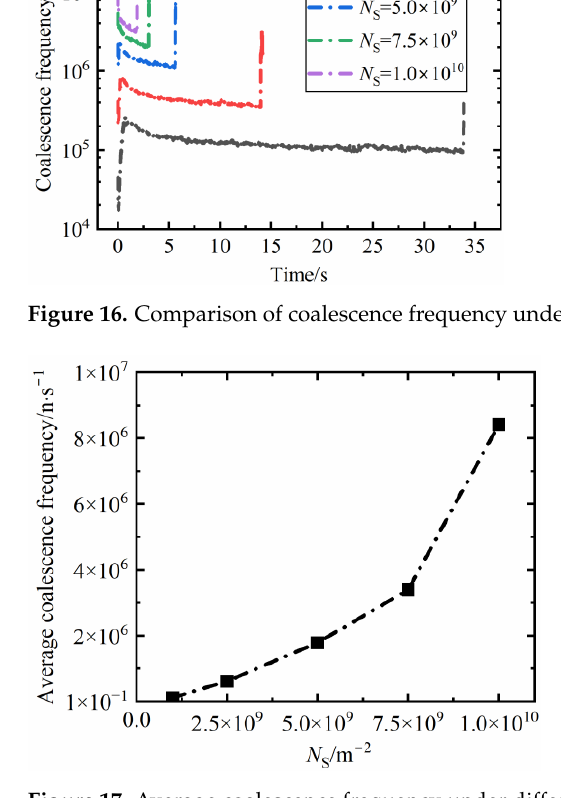
Figure 17. Average coalescence frequency under different nucleus densities.